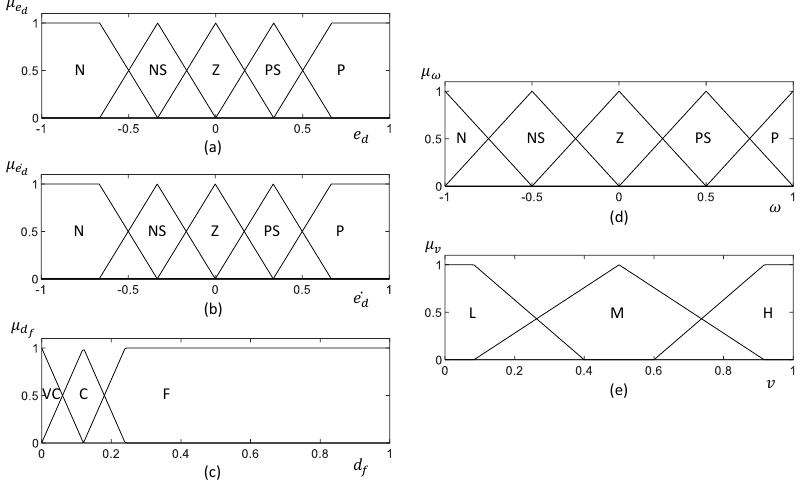
Figure 3. Membership functions of the T1-FLS. ( a – c ) input membership function for e d , ˙ e d , and d f , respectively. ( d , e ) Output membership function for ω and v , respectively. Fuzzy labels are defined